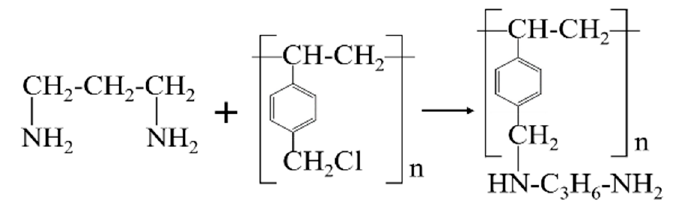
Figure 1. The amination mechanism of ACPS.